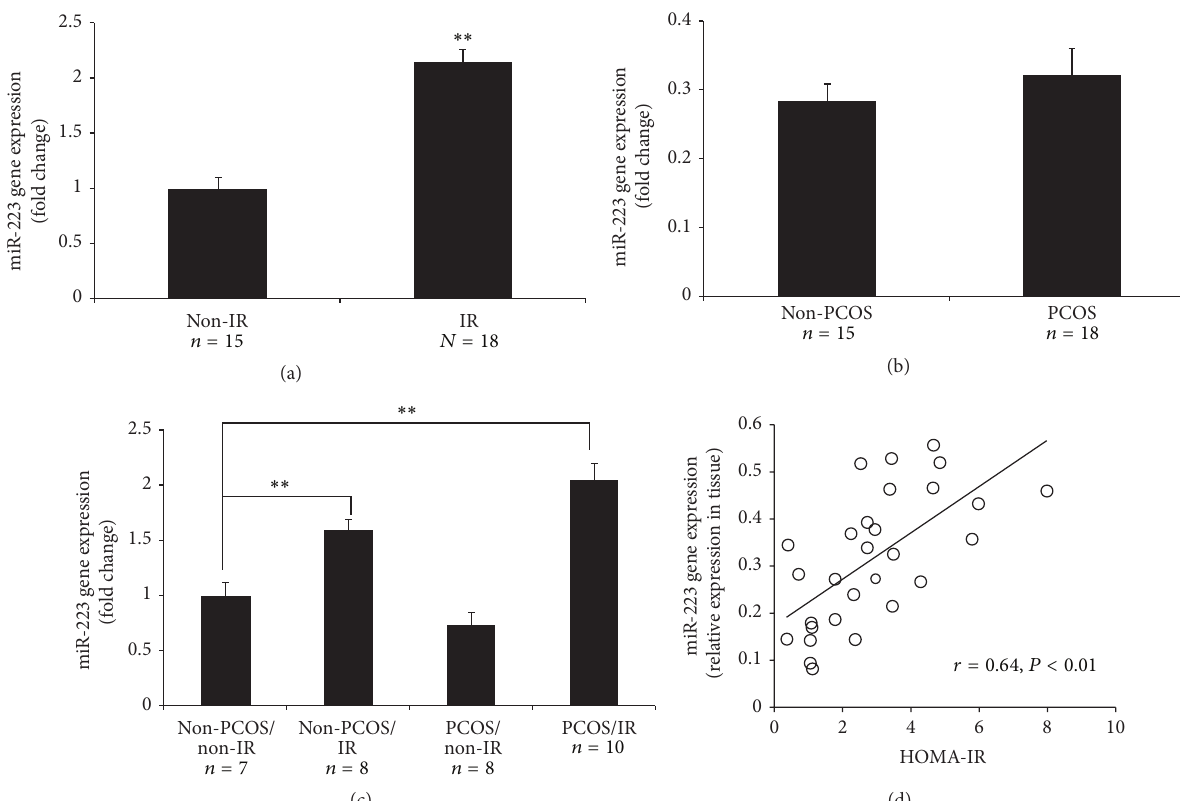
Figure 1: miR-223 expression in human AT. (a) Depicted is comparison of the levels of miR-223 expression in the AT of women with and without IR; miR-223 was significantly overexpressed in the IR group. (b) Depicted is comparison of the levels of miR-223 expression in the AT of women with and without PCOS; the expression of miR-223 did not differ between two groups. (c) Depicted is comparison of the levels of miR-223 expression in the AT of women: (A) without PCOS or IR, (B) without PCOS (non-PCOS), but with IR, (C) with PCOS and IR, and (D) with PCOS, but without IR; the expression of miR-223 was significantly higher in the AT in women with IR. ∗∗ 𝑃 < 0.01 comparing tissues from women with or without PCOS and with IR versus that of women without PCOS or IR. (d) Depicted is the association between miR-223 expression and HOMA-IR. (Two group comparisons, (a) and (b), were carried out by unpaired Student’s 𝑡 -test; comparison of (d) was carried out by ANOVA followed by a posttest by using the Fisher (among groups) and Dunnett (compared to control group) test.)